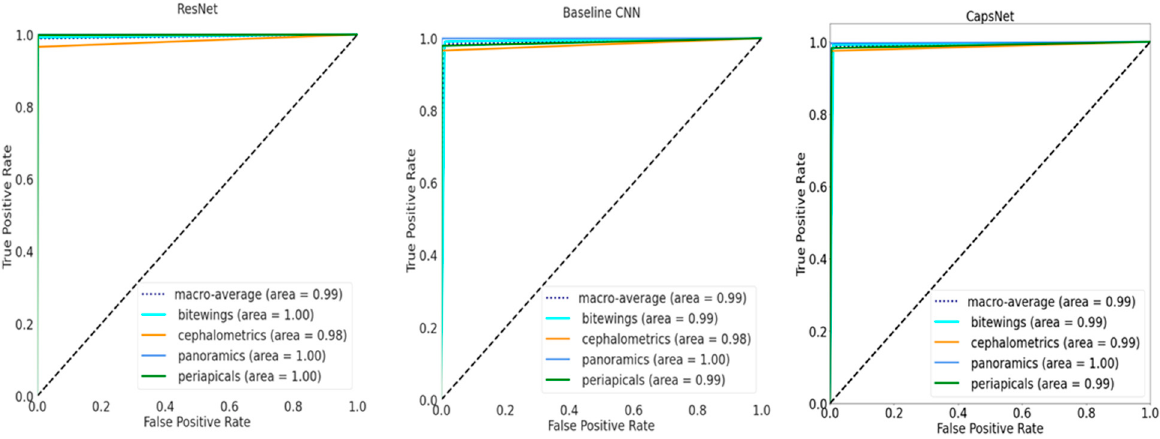
Figure 2. Receiver operating characteristic (ROC) curves on the test set for the three models. The area-under-the-curve for each class are shown. In addition, the macro-average across all classes is shown.